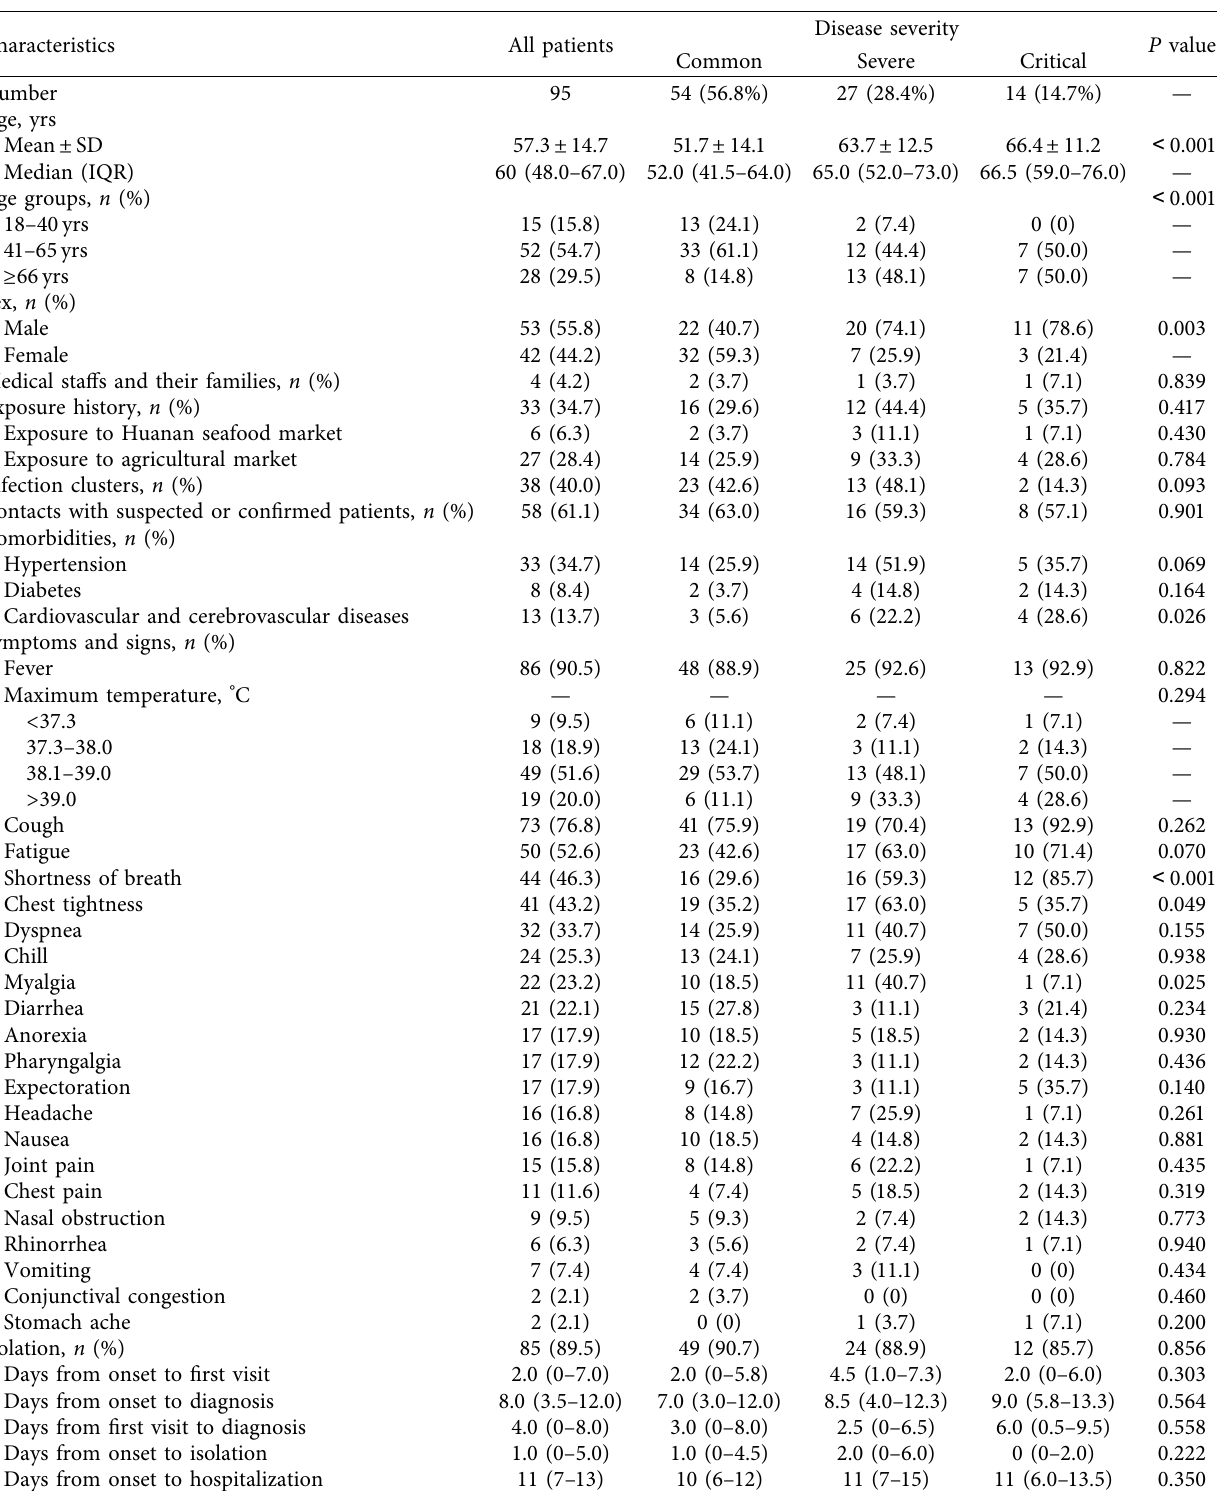
Table 1: Baseline characteristics of COVID-19